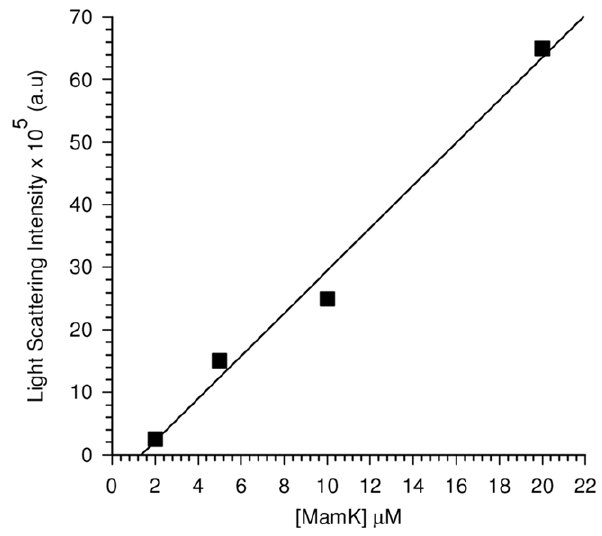
Figure 2. Determination of the critical concentration of MamK. MamK was polymerized in polymerisation buffer in the presence of ATP (0.2 mM) for 1 hr and equilibrated to room temperature. The scattering light intensity was measured for a series of concentrations of MamK. The critical concentration extrapolated from the linear plot was determined to 1.4 m M.